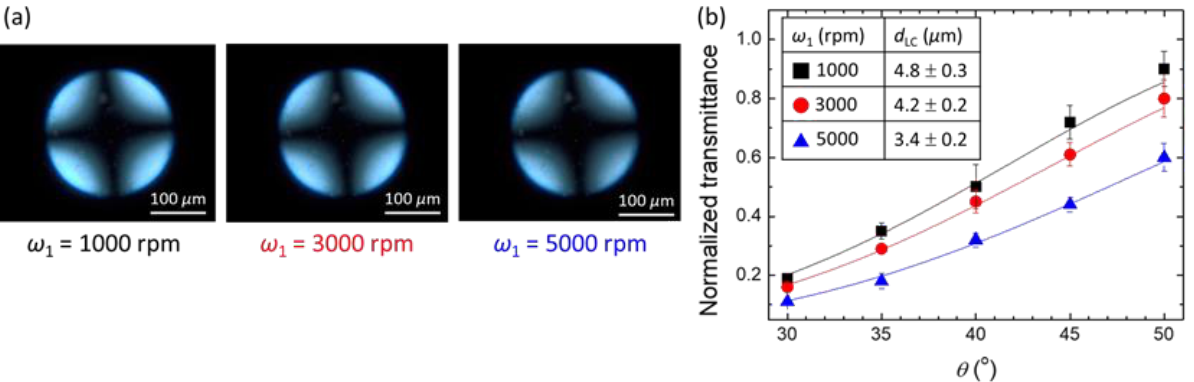
Figure 4. Correlation between spin rate and LC film thickness. The E7 film was spin-coated on DMOAP substrates with a two-step procedure in which the spin rate of the first step ω 1 = 1000, 3000 or 5000 rpm and that of the second step ω 2 = 5000 rpm, with each step lasting for 10 s. ( a ) Conoscopic images of LC films spread at various ω 1 observed under a POM. Each error bar denotes the standard deviation calculated from the transmission values of five independent measurements. ( b ) Dependence of transmittance on incident angle of light θ measured with the optical setup in Figure 1. The values of E7 film thickness displayed in the inset of ( b ) were deduced by fitting the experimental results with Equation (1).